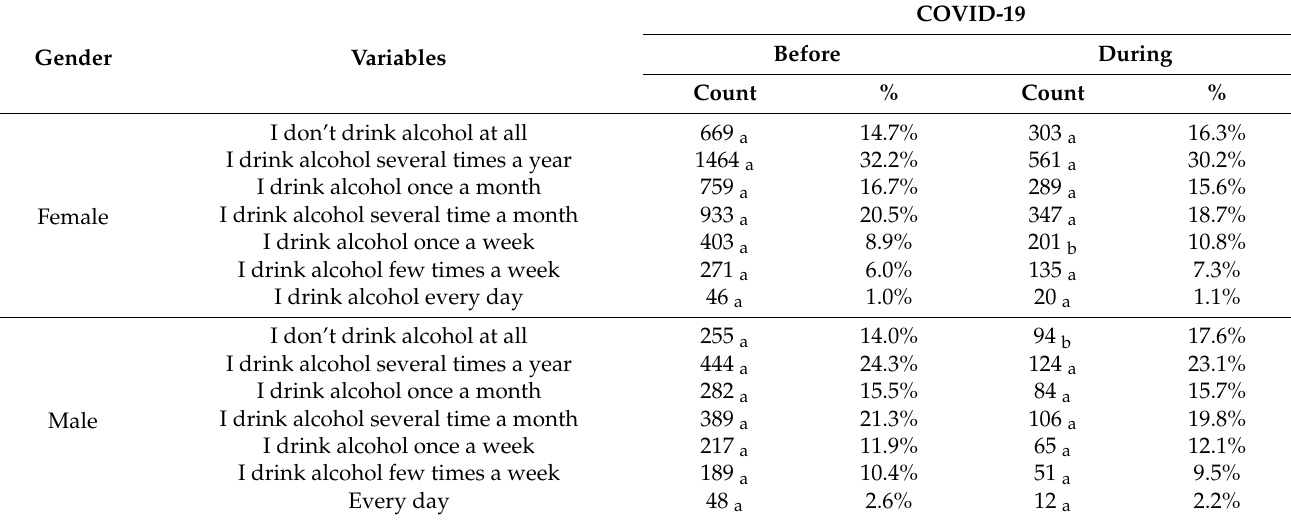
Table 2. Alcohol consumption before and during COVID-19.